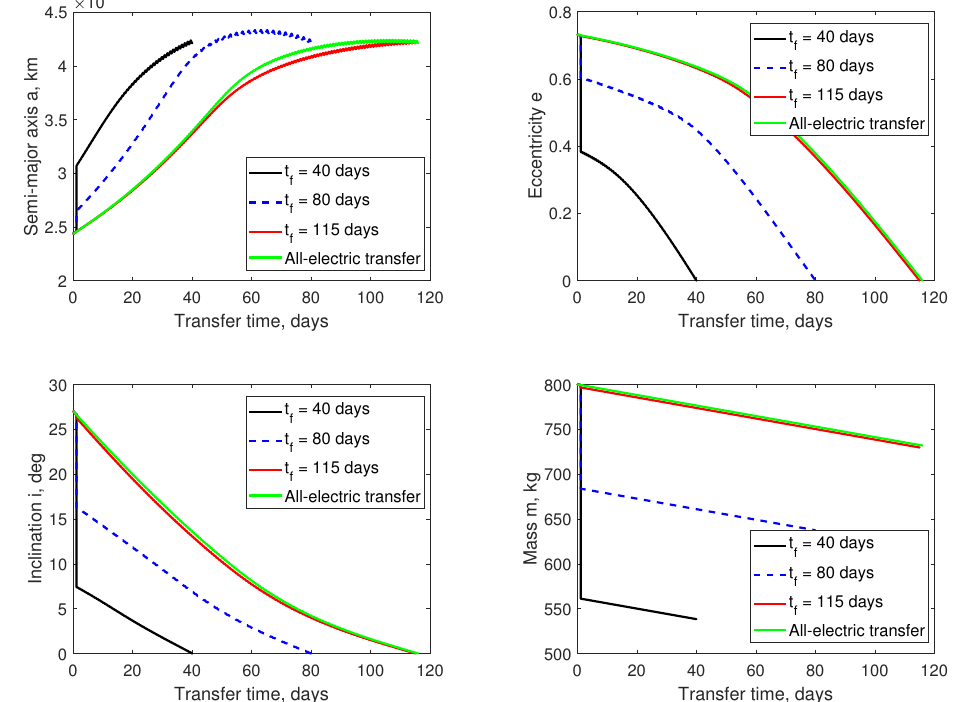
Figure 4. The time histories of the semi-major axis, eccentricity, inclination and mass of hybrid transfer orbit with transfer time of 40 days, 80 days, 115 days and all-electric transfer orbit.